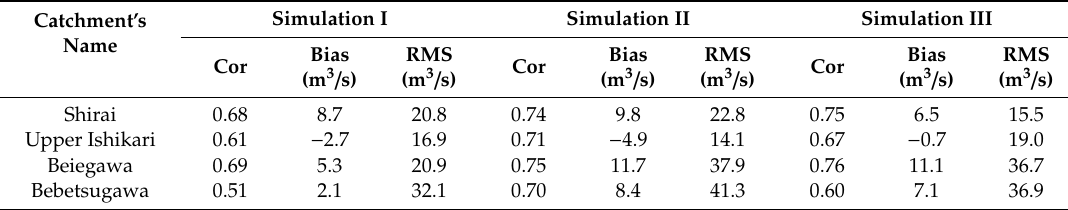
Table 3. Comparison of the performance of simulated vs. observed river discharge during flash flood event on 23 and 24 August